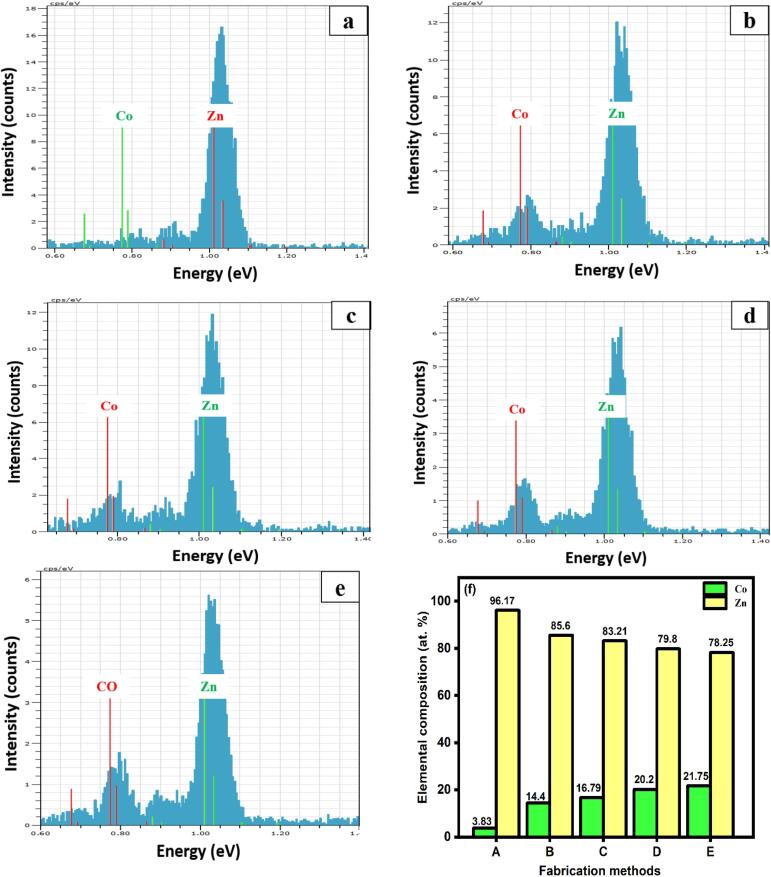
EDX profile quantitative analysis spectrum of prepared Zn-Co film by a) Conventional method, b) SC-CO2 1500 psi, c) SC-CO2 2000 psi, d) US-SC-CO2 1500 psi, e) US-SC-CO2 2000 psi, and f) average elemental percentage composition of fabricated films.